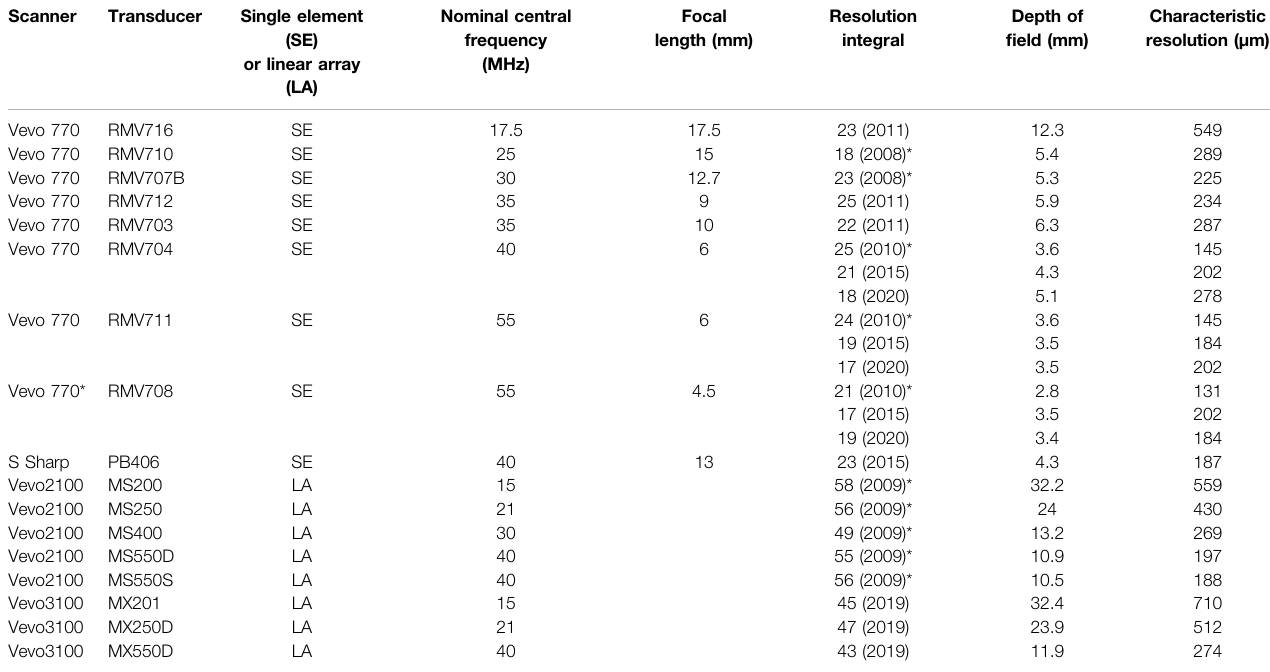
TABLE1| Detailsofthe17preclinicalultrasoundtransducersandtheirperformancemeasurements.*indicatesdatathatwaspublishedpreviously[14].Notethatforthreeof the transducers, performance values, obtained in 2020 when the Vevo 770 scanner was decommissioned are also included.